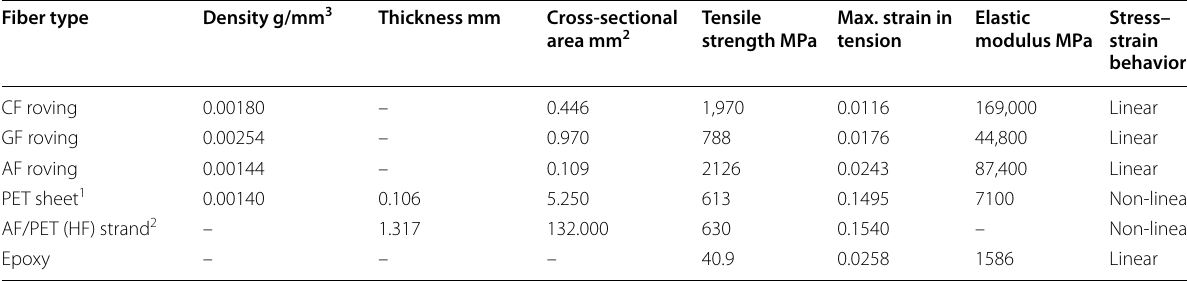
CF is carbon fiber; GF is glass fiber; AF is aramid fiber; PET is polyethylene terephthalate 1 Cross-sectional area for bi-axially-woven PET sheet is given for axial direction only per 100 mm width; 2 AF/PET hybrid strand consists of 120.8 mm 2 PET and 10.9 mm 2 AF per 100 mm width